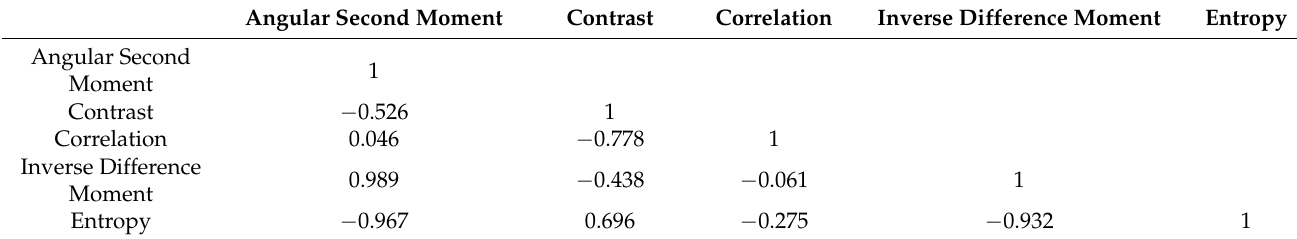
Table 4. The correlation matrix of set Z2.